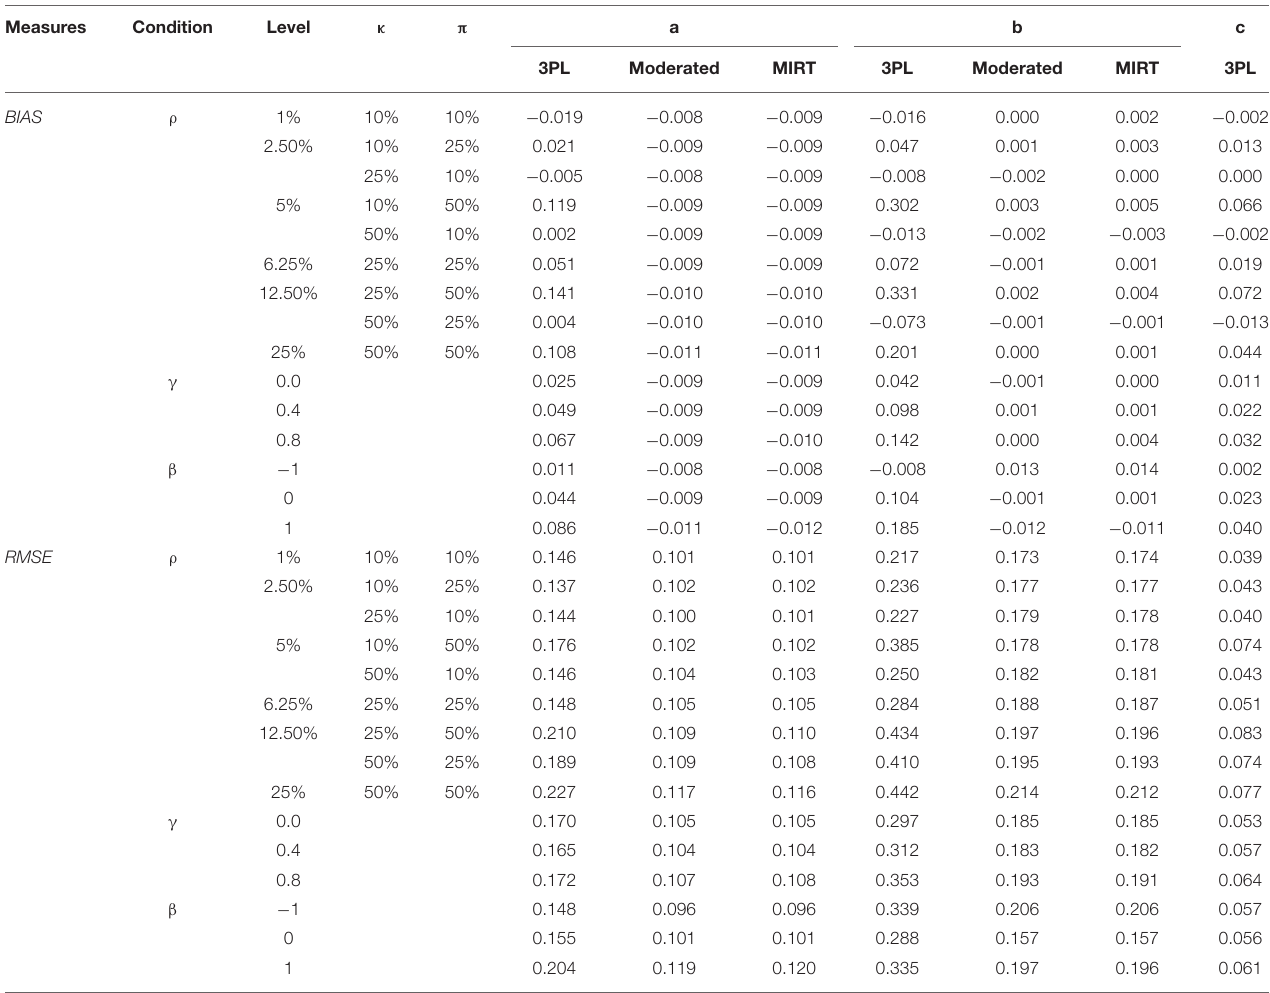
TABLE 1 | BIAS and RMSE of item parameter estimates under different models in study I. Measures Condition Level κ π a b